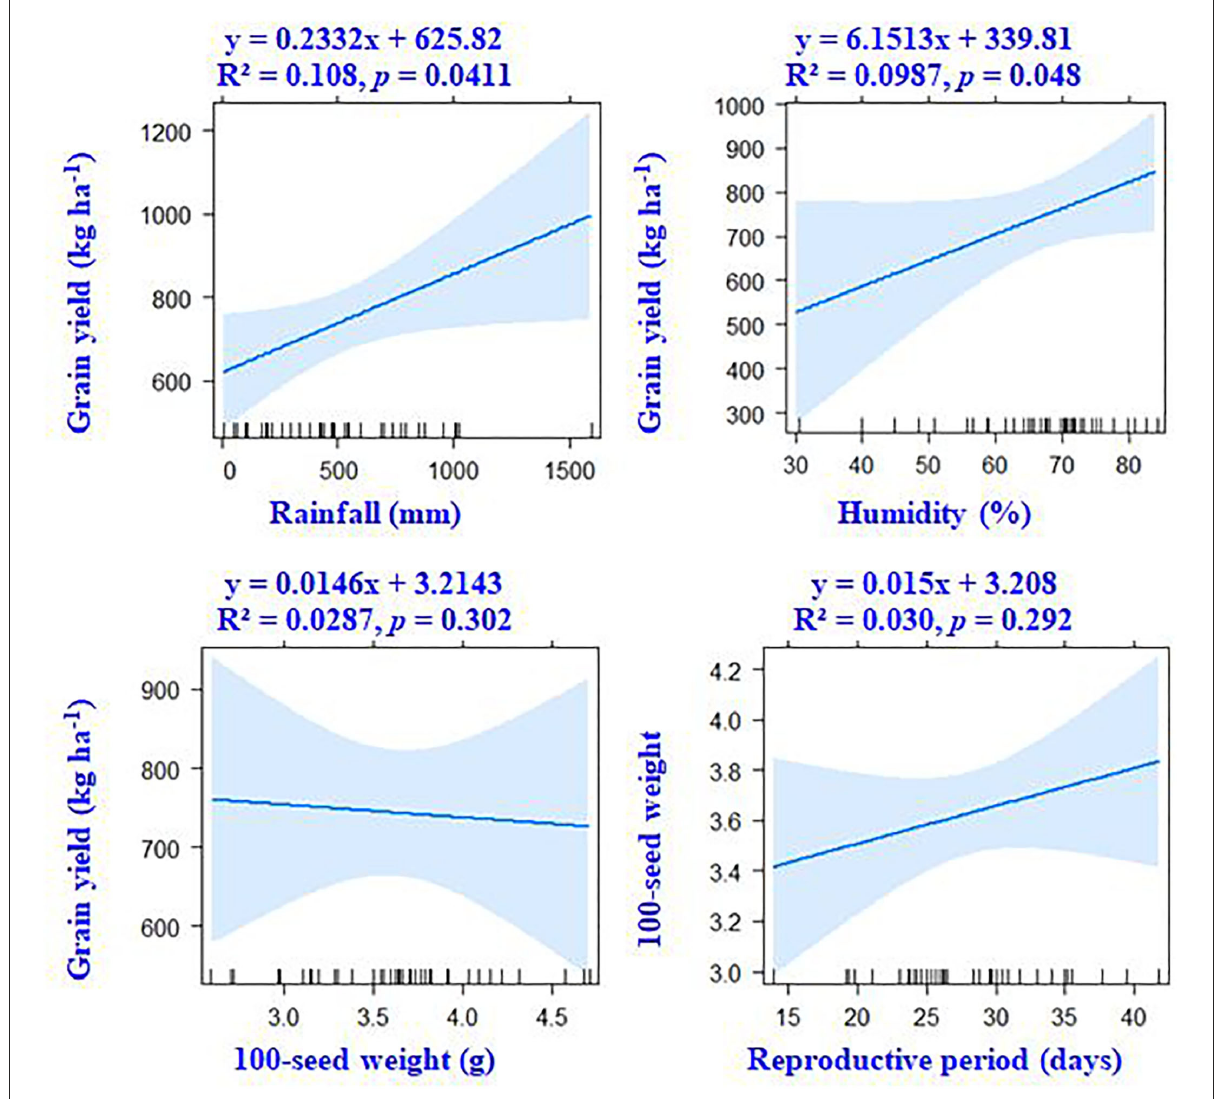
FIGURE5 According to linear regression models, there are associations between grain yield, weather parameters, and the seed weight of